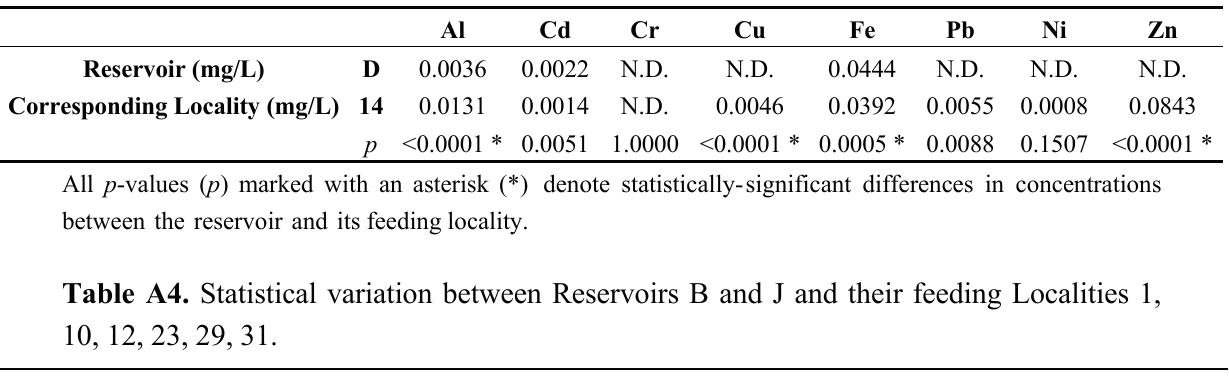
Table A3. Statistical variation between Reservoir D and its feeding Locality 14.